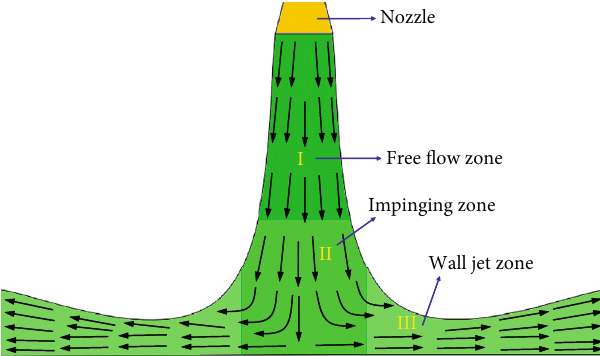
Figure 3: Schematic diagram of gas jet development